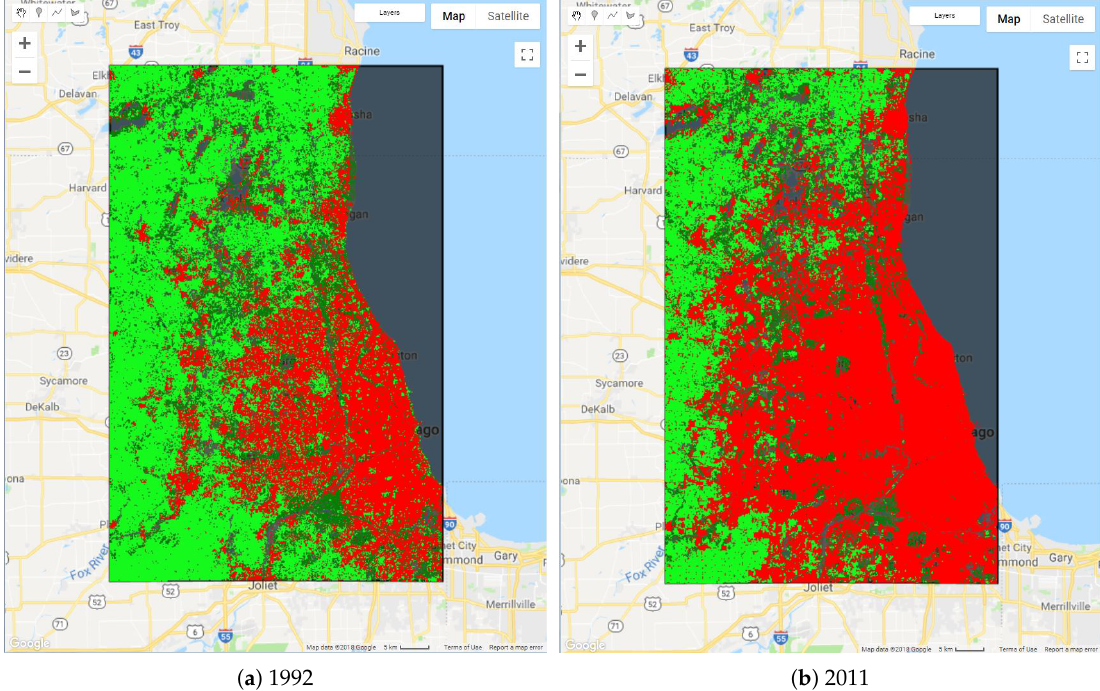
Figure 14. Chicago MA: LC situation in 1992 ( a ) and in 2011 ( b ). In red, the Urbanized class, in light green, the Cultivated class, in dark green, the Forest and Shrubland classes.